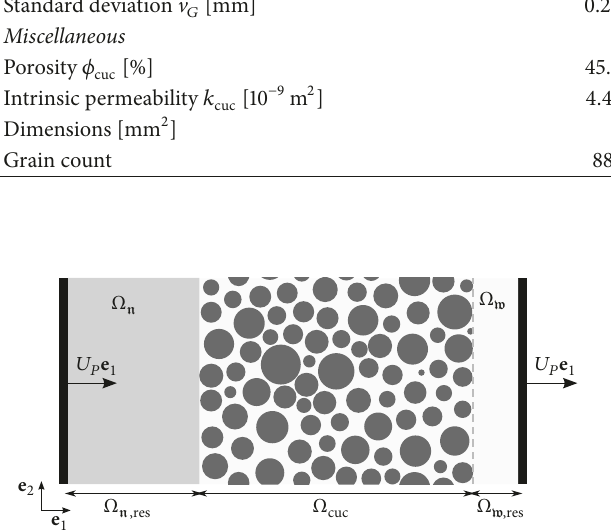
Figure1:Schematicdiagramofsimulationsetupatinitialtime 𝑡 = 0 . Black bars represent displacing